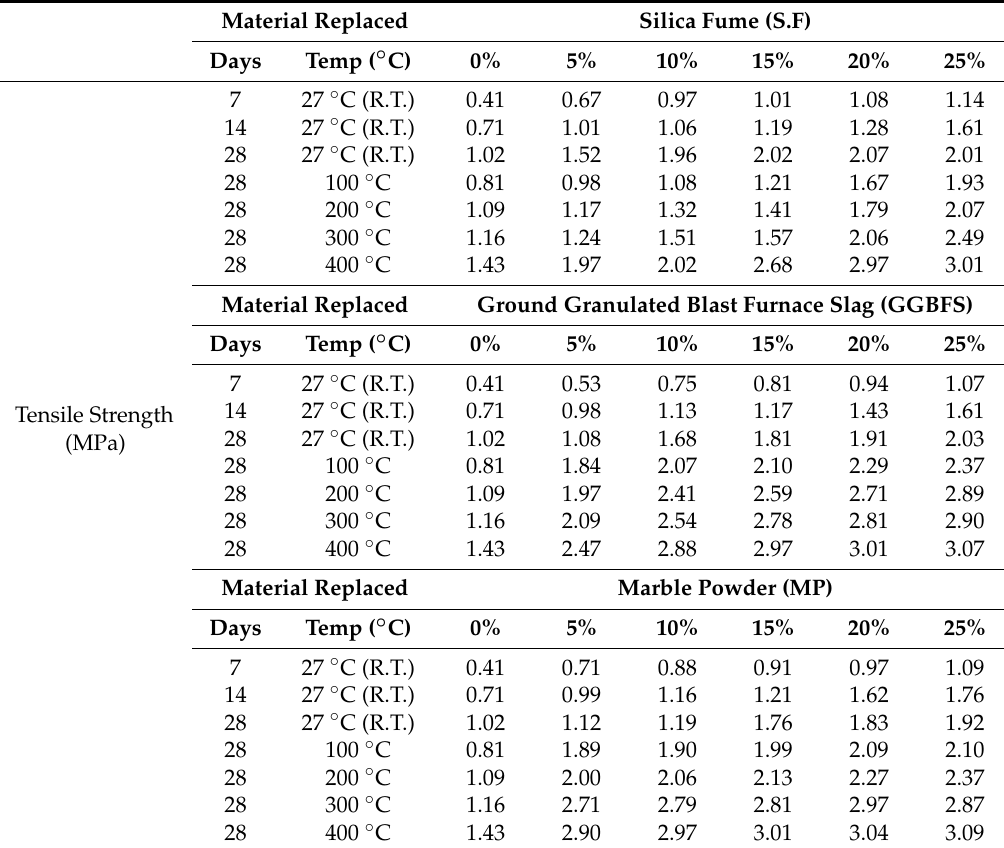
Table 5. Test results for hardened self-compacted concrete (tensile strength, MPa). Material Replaced Silica Fume